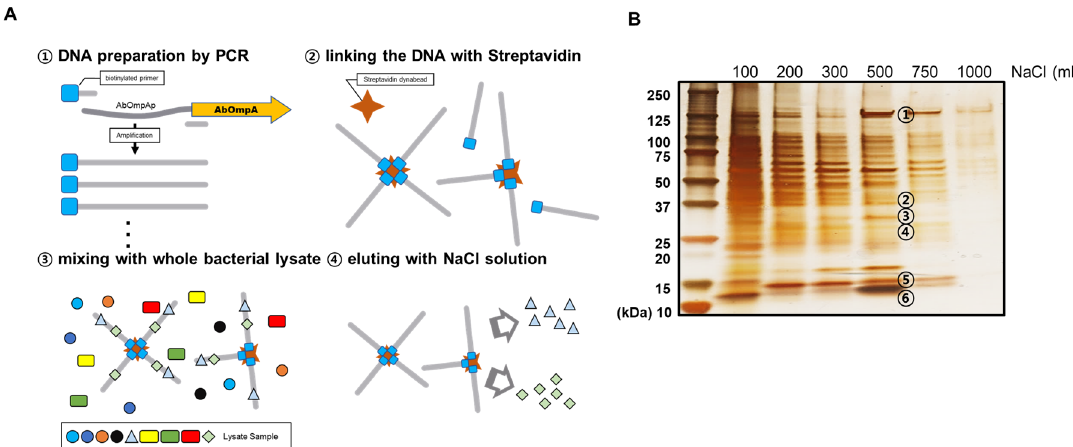
Figure 2. Identification of proteins that bind to the AbOmpA promoter. The diagram depicts the overall scheme of the DNA affinity chromatography experiment ( A ). The proteins eluted from the DNA affinity chromatography were loaded onto 4%–15% gradient SDS–PAGE and developed via silver staining ( B ). The bands with noticeable thickness in the 500 mM NaCl lane were chosen for identification via LC-MS/MS. The specific information of the identified proteins is listed in Supplementary Table S2.